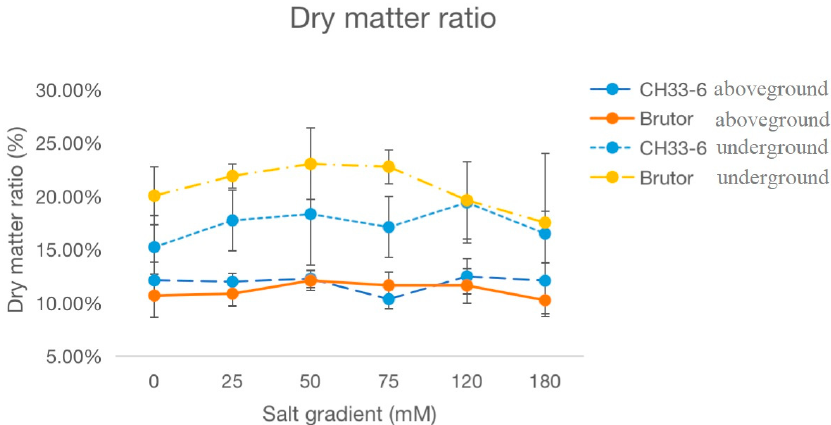
Figure 2. Effects of different salinity levels on the dry matter ratios of aboveground and underground parts of two Brassica napus varieties, CH336 (semi-winter type) and Brutor (spring type), measured at early flowering stage in pot cultures. Bars indicate standard deviation (SD) of the means.